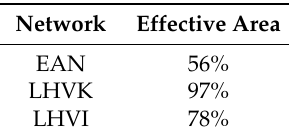
Table 2. Effective reception area of the GW